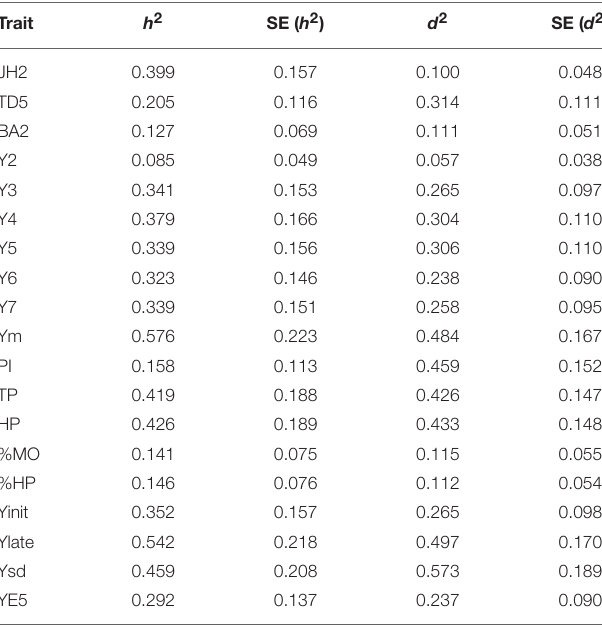
TABLE 3 | Genetic gains. Trait Favorable Top 1% Top 5% direction